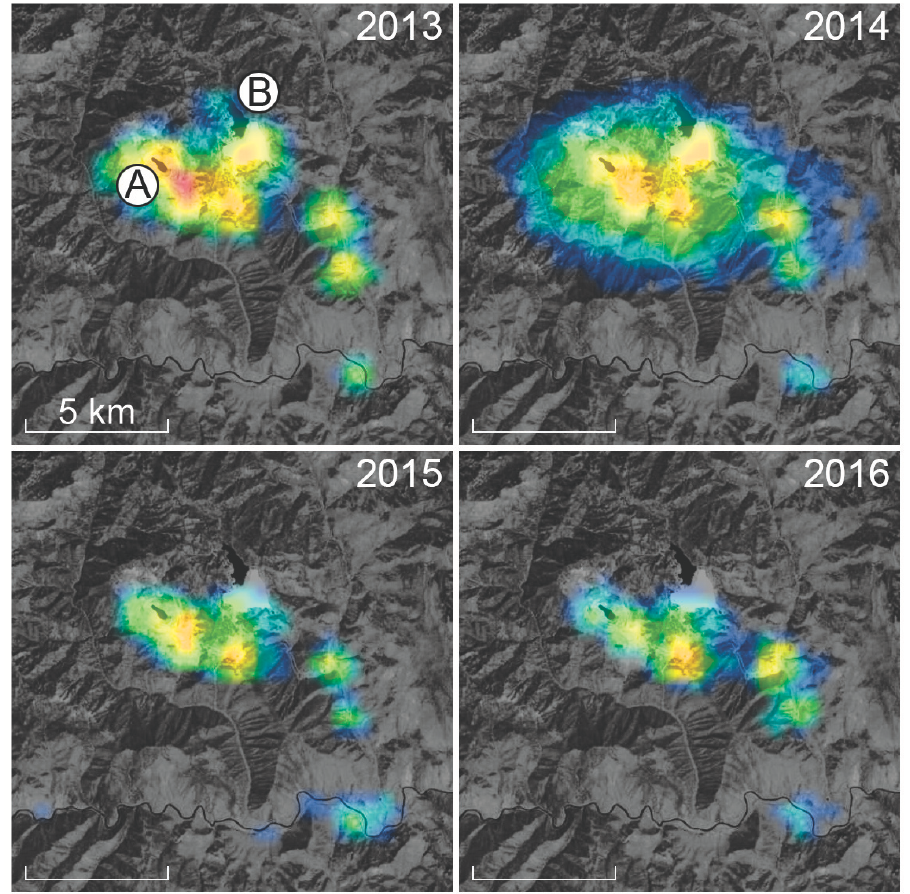
Figure 1. Evolution of the upward radiance from nighttime operations at the Thompson Creek Mine in Custer County, Idaho, U.S., between 2013 and 2017. In each of the four panels, color-coded Visible Infrared Imaging Radiometer Day-Night Band (VIIRS-DNB) radiance data from the National Oceanic and Atmospheric Administration/NASA Suomi National Polar-orbiting Partnership satellite are overlaid on a grayscale Landsat 8 Operational Land Imager context image obtained on 24 July 2016. The colors used to map the VIIRS-DNB radiance data range from 0.25 (darkest blue) to 40 (red) in units of nW cm − 2 sr − 1 . The images are centered near 44 ◦ 17 (cid:48) 52.7 (cid:48)(cid:48) N 114 ◦ 31 (cid:48) 21.7 (cid:48)(cid:48) W and are oriented following the usual cartographic convention of north up, east right. A 5-km scale bar is shown in the lower left corner of each frame. The labels “A” and “B” in the upper-left panel indicate the open-pit molybdenum mine and its tailing pond,